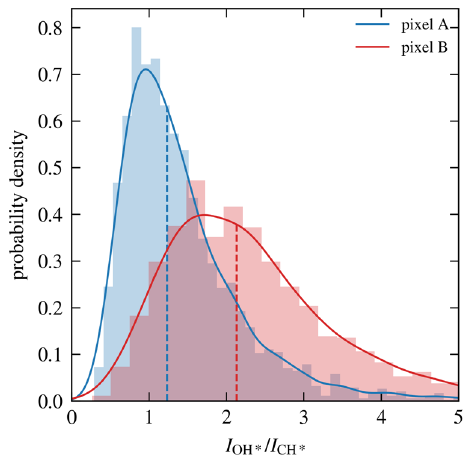
Figure 19. Probability density function (PDF) of the intensity ratio distribution of the turbulent methane/air diffusion flame in Figure 18, evaluated at pixel regions A and B.